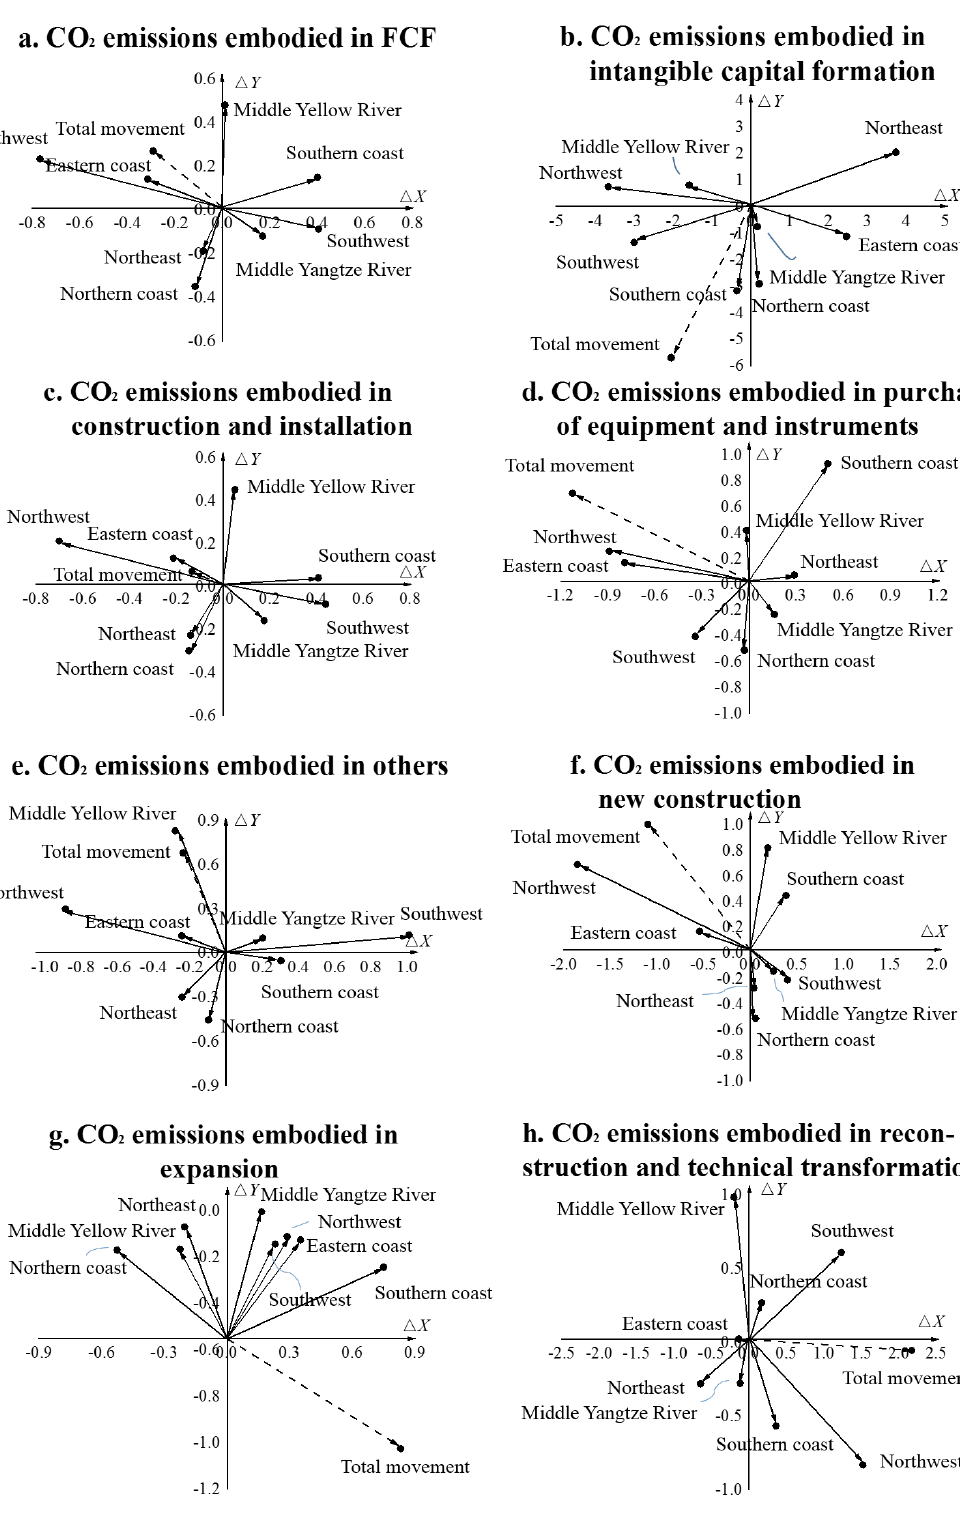
Figure 6. Regional con tributions to the gravity movement of China’s CO 2 emissions embodied in FCF during 2002 – 2015. during